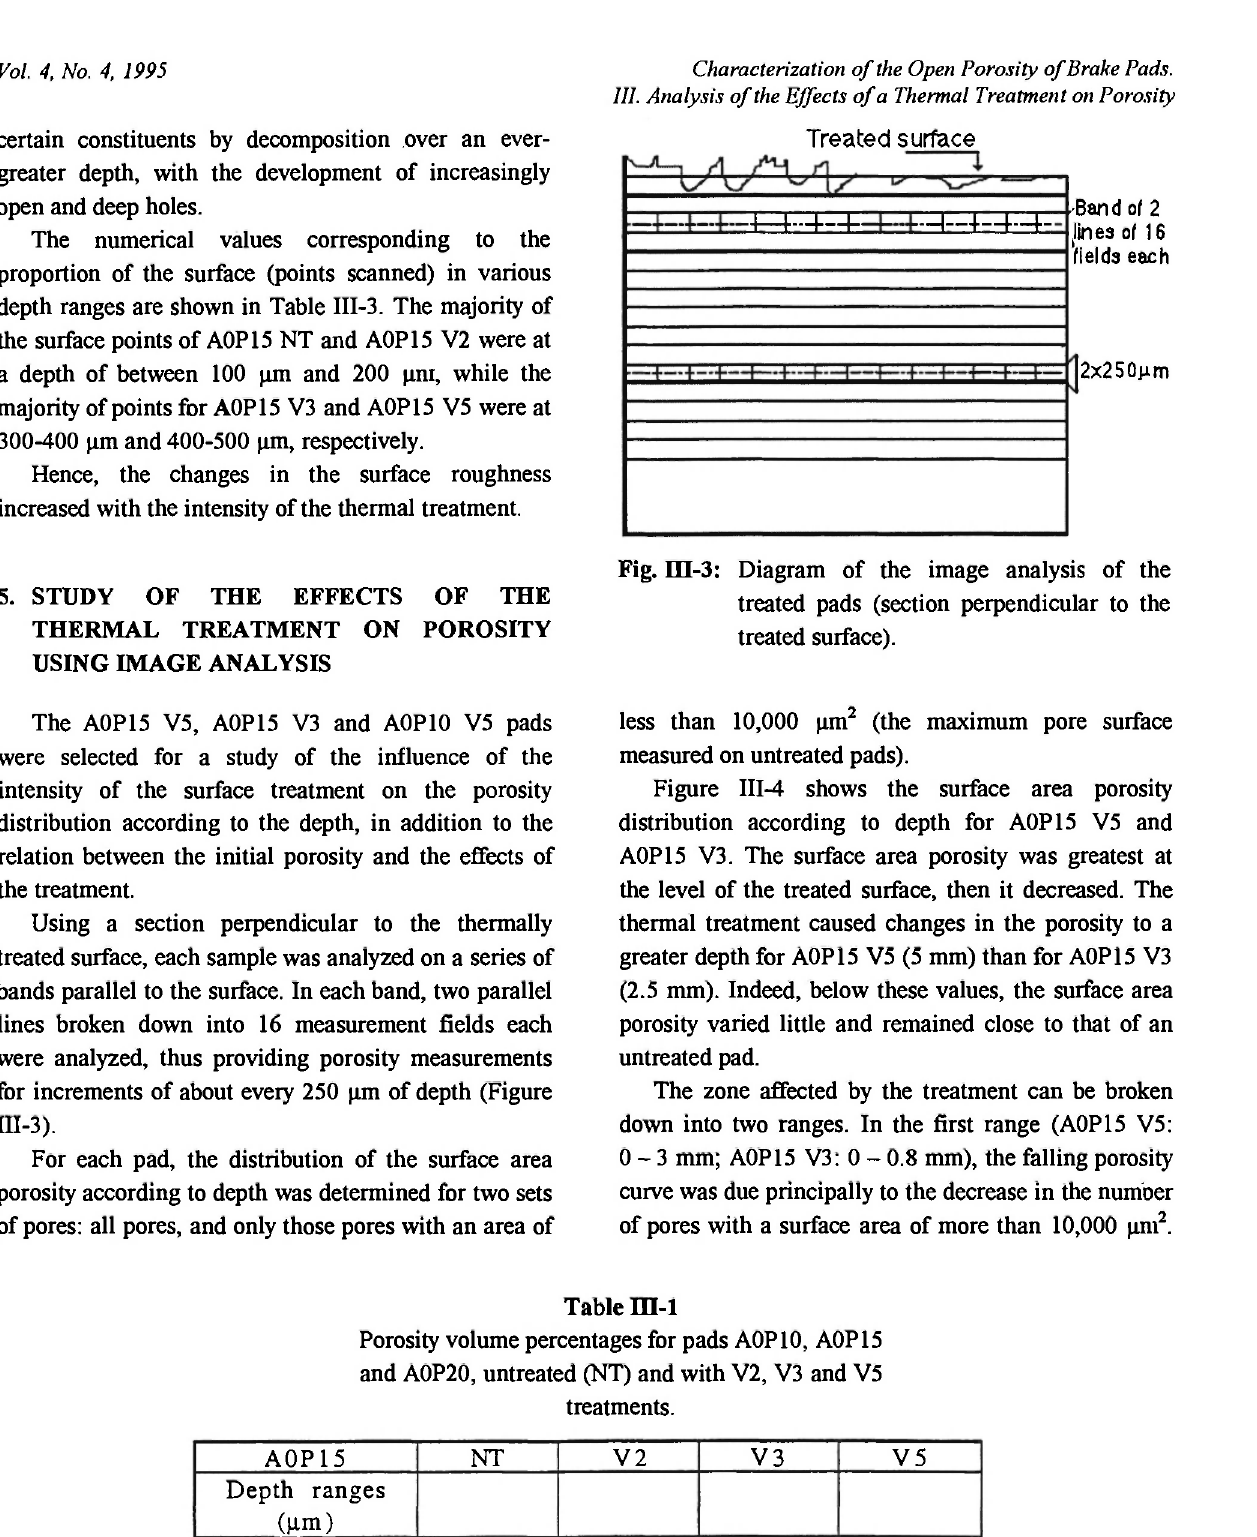
Porosity volume percentages for pads A0P10, A0P15 and A0P20, untreated (NT) and with V2, V3 and V5